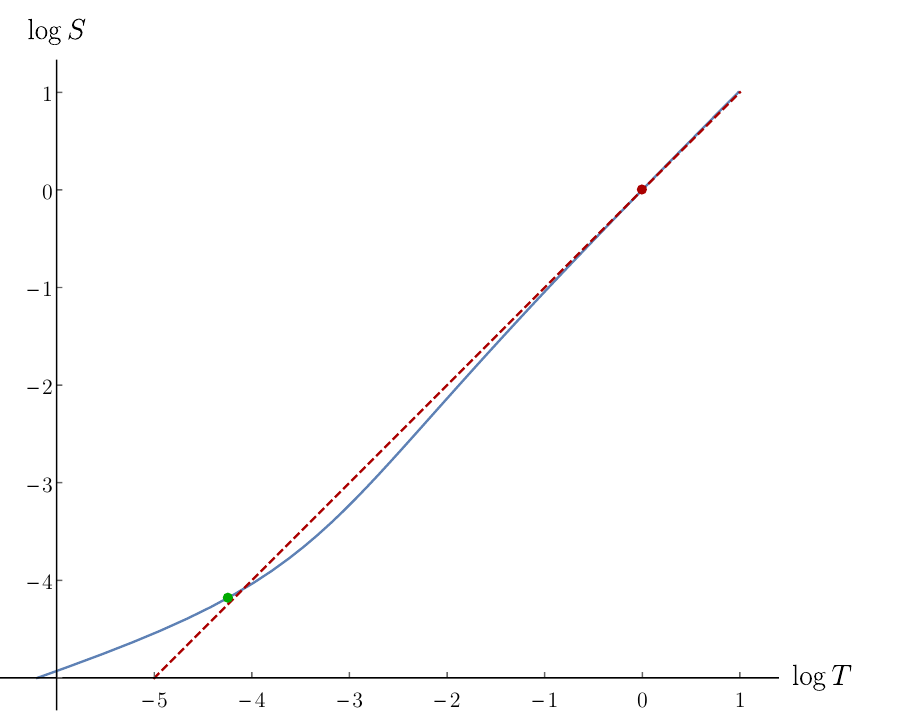
Figure 4 . Plot log-log of the scale factor S (in blue) as a function of the cosmological time T . It corresponds to the ( λ, k ) -compactification (with l = 2 ). The green dot corresponds to the beginning of inflation; the red one to its end. The red dashed line coincides with the Milne fixed point S ∝ T and asymptotes the curve at future